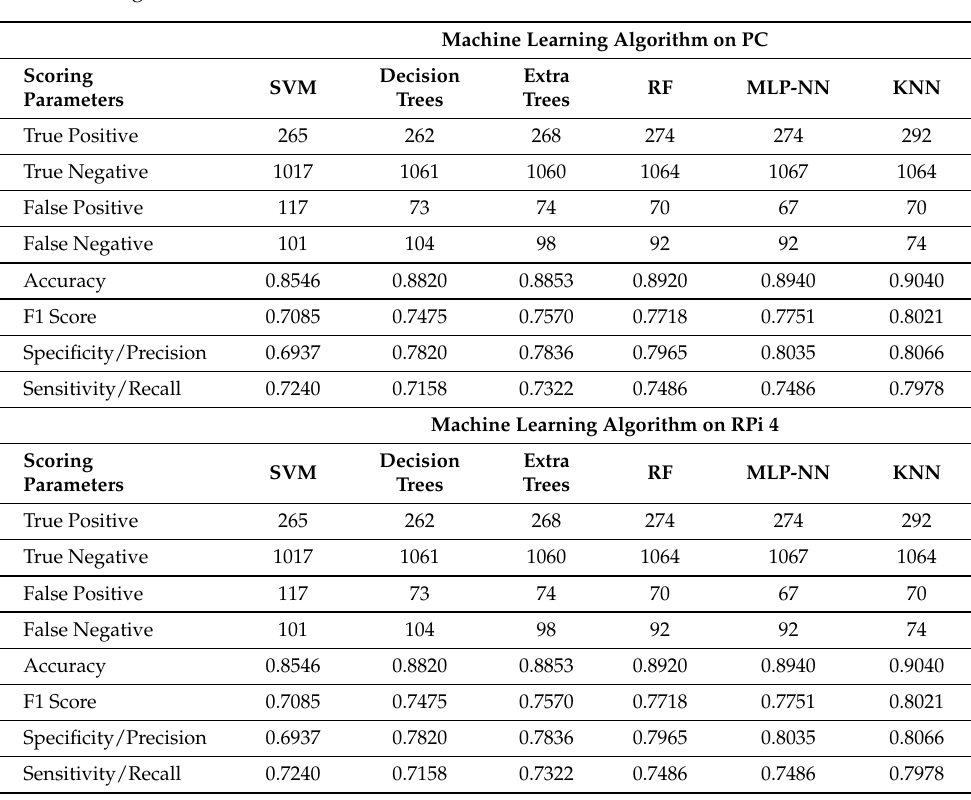
Table 7. Scoring parameters of the ML algorithms evaluated in this study using 15% of the separated data for